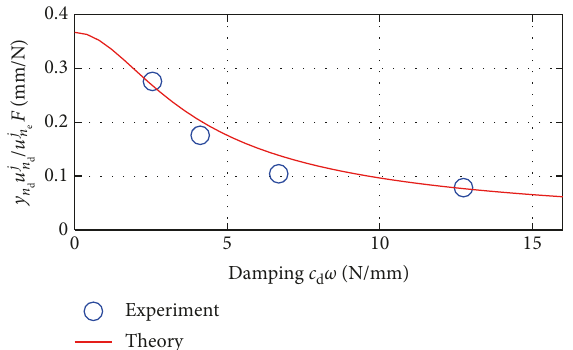
Figure 6: Relationship of displacement amplitude to damping at the damper’s location.